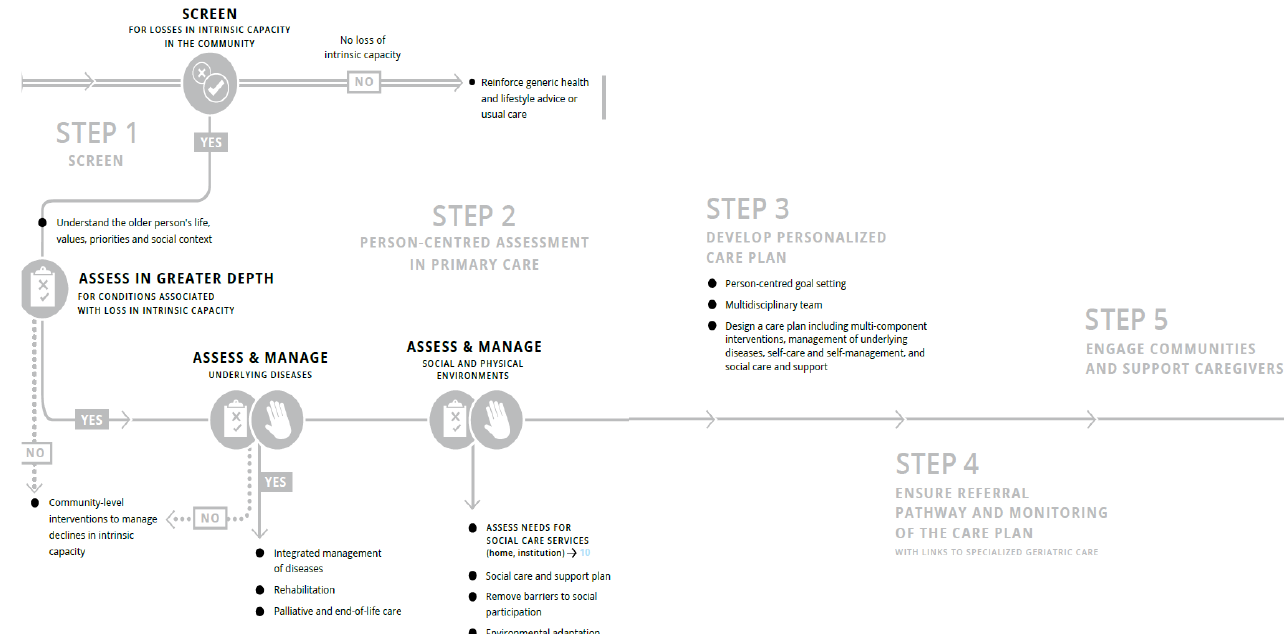
Figure 1. ICOPE Steps 1 to 5. Derived from